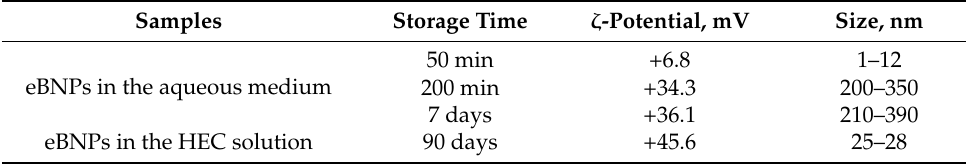
Table 1. Stability of nanoparticle colloidal solutions.